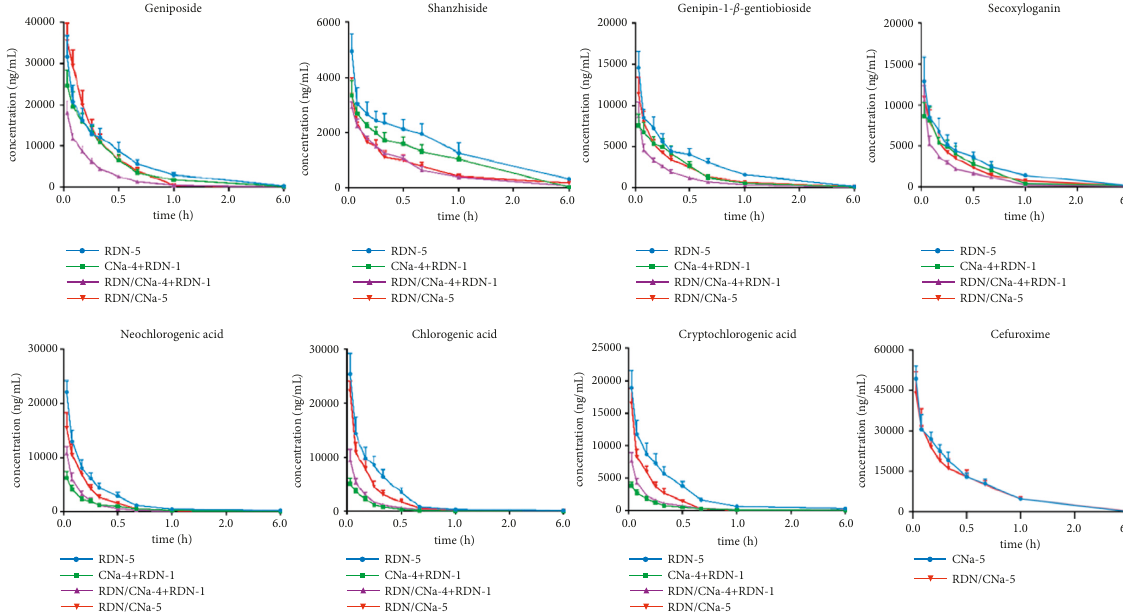
Figure 5: The mean plasma concentration-time profiles of seven analytes with cefuroxime after multiple coadministration of RDN and